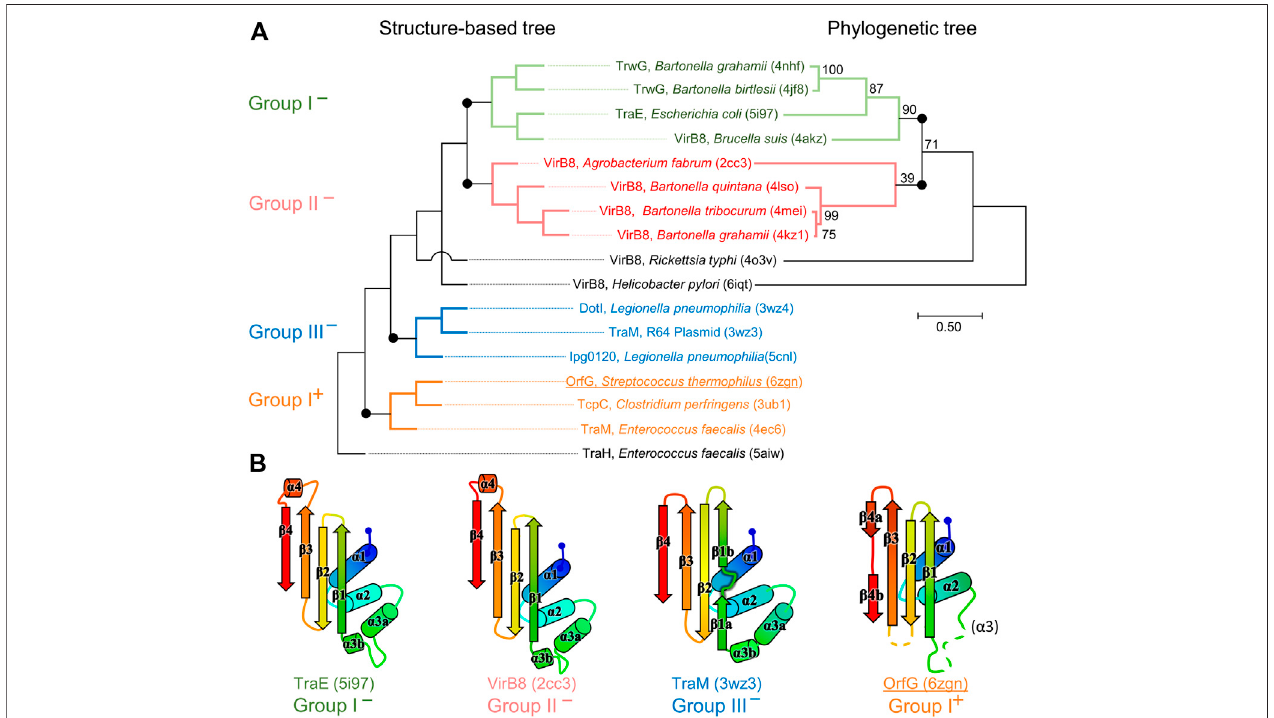
FIGURE 4 | Structural and phylogenetic trees of Gram-negative VirB8 and Gram-positive VirB8-like proteins. (A) Structure-based tree derived from the optimized superposition of theatomic coordinates (left) . 17 representative structures were retrieved from the PDB and compared by mTM-align(Dong et al., 2018a).The name of theprotein,itssourceandPDBidareindicatedforeachprotein.MembersofclassI − areingreen,classII − inred,classIII − inblue,andclassI + inorangewherethe( − )and ( + ) correspond to VirB8-like structures from Gram-negative and -positive bacteria, respectively. (B) Secondary structure topology observed within each class is schematized at the bottom of the fi gure. Among the proteins compared in the structural analysis, all the sequences that belong to the PFAM group PF04335 were subjected to multiple sequence alignment and neighbor-joining tree building. The result is shown on the right-hand side of the fi gure. Numbers at nodes indicate the bootstrap values as percentage (1,000 replicates). Scale bar indicates the number of amino acid differences per